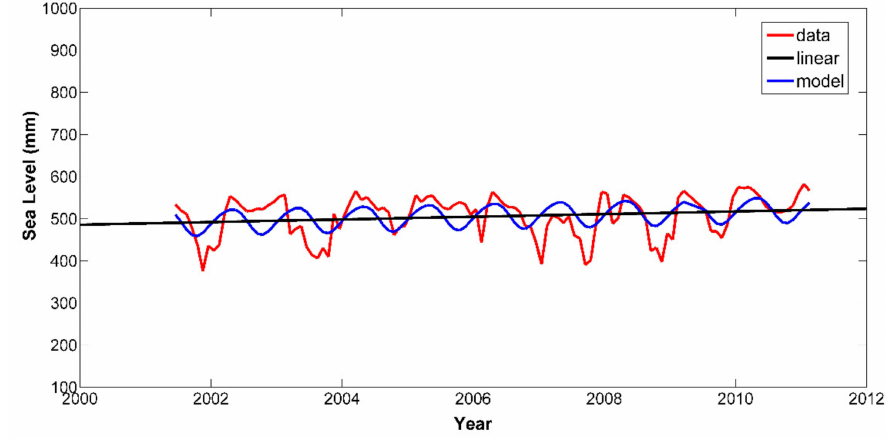
Figure 6. Trend and harmonic model of ~10-year sea level time series at the Amasra tide gauge